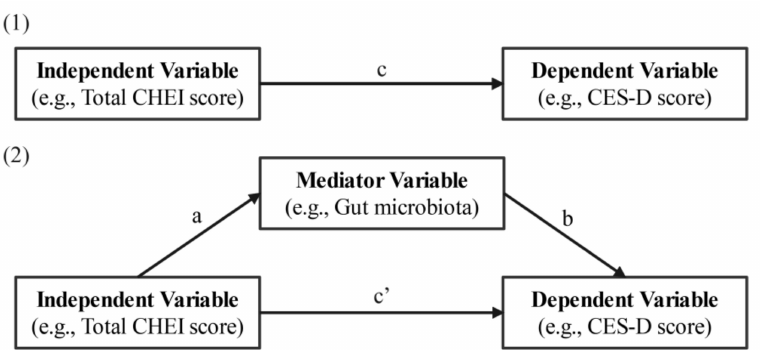
Figure 1. The single-mediator model used to test the association between the nutrients or total CHEI score (i.e., independent variable) and CES-D score (i.e., dependent variable), with the gut microbiota as a mediator: ( 1 ) Path c represents the simple total effect of the nutrients or total CHEI score on the CES-D score, without adjusting for mediators; ( 2 ) represents the direct (Path c’) and indirect effects (product of Paths a and b, ab) of the nutrients or total CHEI score on the CES-D score after controlling for the effect of the mediator. CES-D, Center for Epidemiologic Studies Depression; CHEI, Chinese Healthy Eating